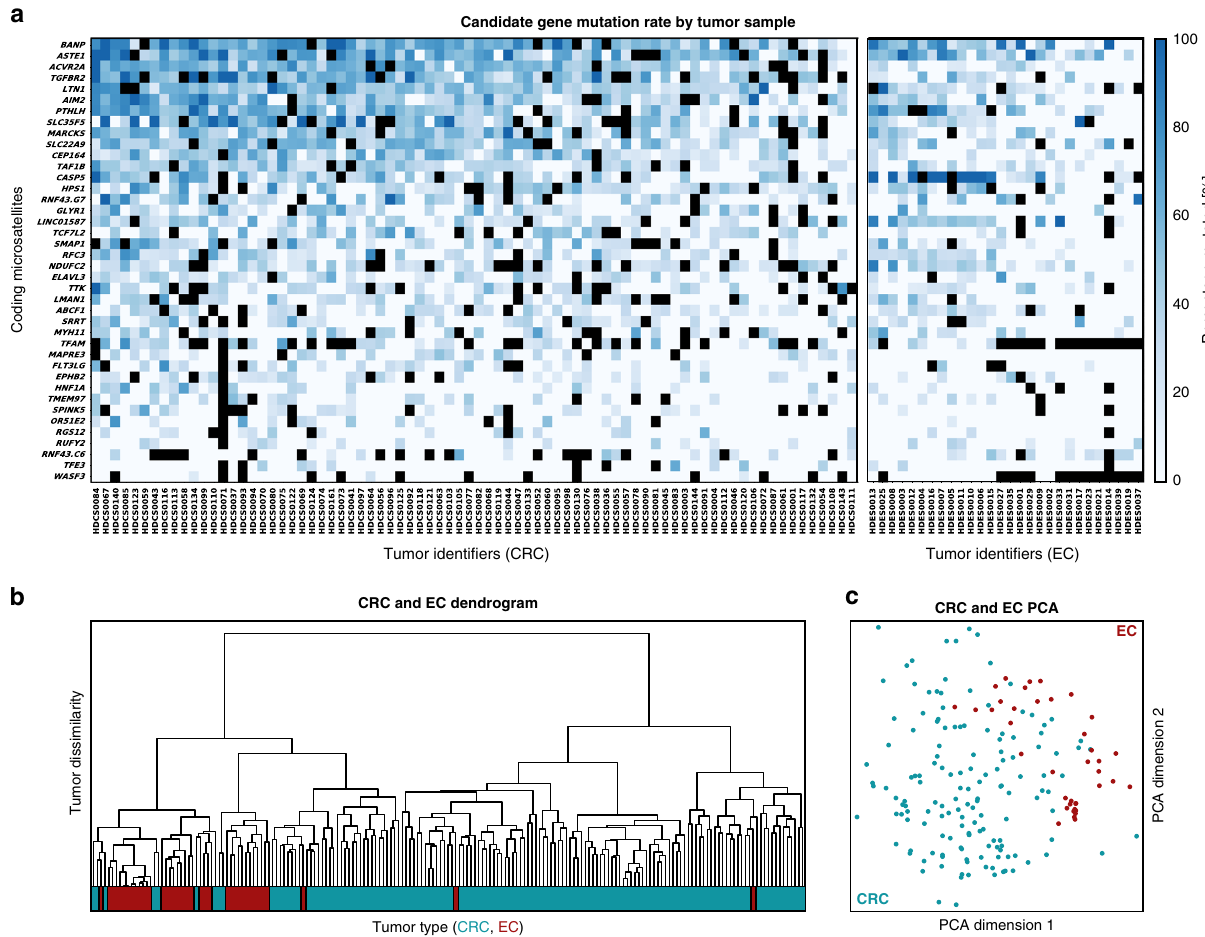
Fig. 1 Mutation frequencies of cMS in MSI CRC and EC. a The relative frequency of mutant alleles is shown for 41 cMS (rows) in CRC and EC tumor samples (columns) derived using ReFrame. cMS were sorted top – down according to their mutation frequency indicated by blue boxes of different intensity. Dark blue represents high mutation frequency, whereas pale blue represents low mutation frequency and white absence of mutations. Black boxes indicate missing data points. The respective tumor samples are shown below each column. cMS were analyzed for both CRC and EC and are depicted separately for each tumor type (left panel: CRC, right panel: EC). The complete dataset is provided in Supplementary Fig. 2. Source data for Supplementary Fig. 2 are provided as a Source Data fi le. b Dendrogram of CRC and EC samples with respect to their mutation patterns where the color bar below indicates the tumor type (CRC, blue; EC, red). c Principal component analysis of EC (red) and CRC (blue) samples with respect to their mutation frameshift peptide was 23 (for the M1 frame of P4HB ), (low af fi nity: 92 predicted putative epitopes in M1 SPINK5 ; very low af fi nity: 375 predicted putative epitopes in M1 P4HB ). Other cMS mutation-induced frameshift peptides showed a complete lack of the predicted epitopes (Fig. 3 and Supplementary Data 2).